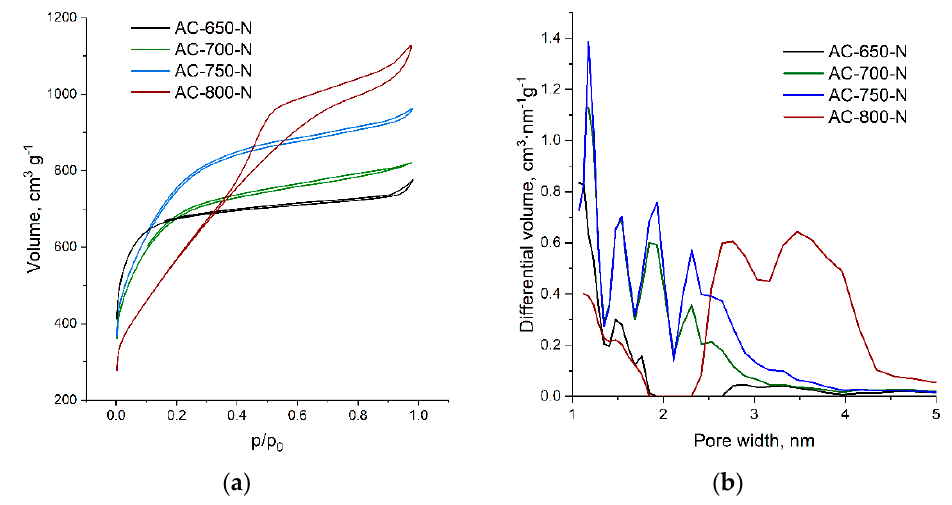
Figure 1. N -doped, wood-based activated carbon nitrogen sorption isotherms at 77 K ( a ) and pore size distributions ( b ), depending on activation temperature. Table 1. Porosity, yield and elemental composition of nitrogen-doped, wood-based activated carbons.